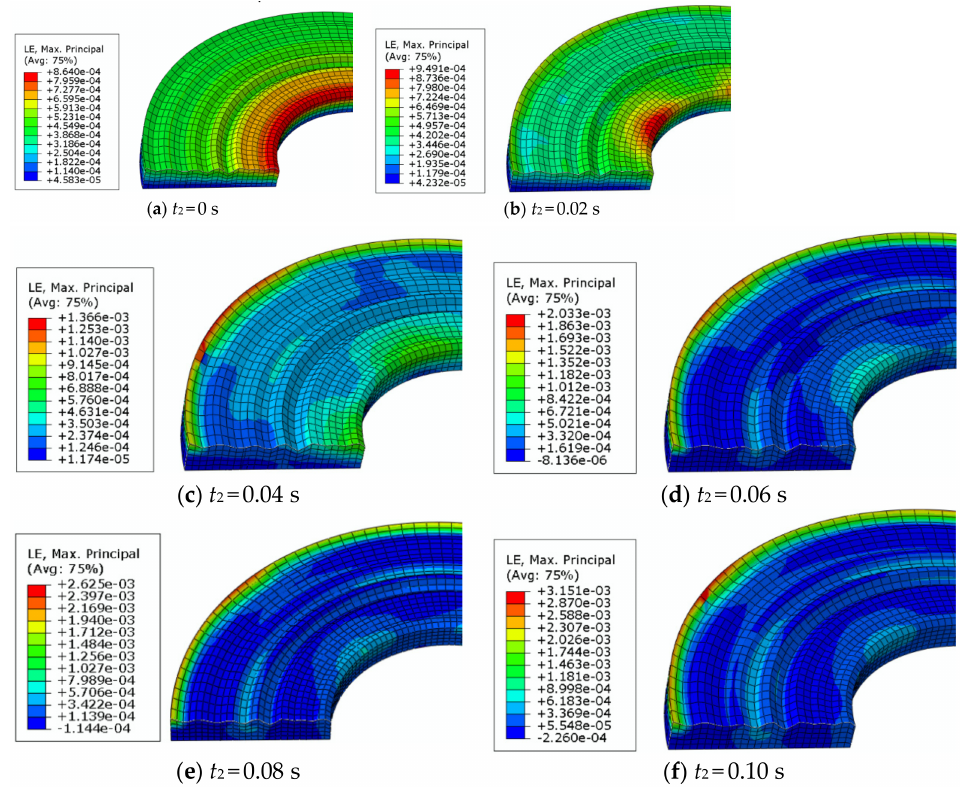
Figure 8. Strain analysis of the friction pair.